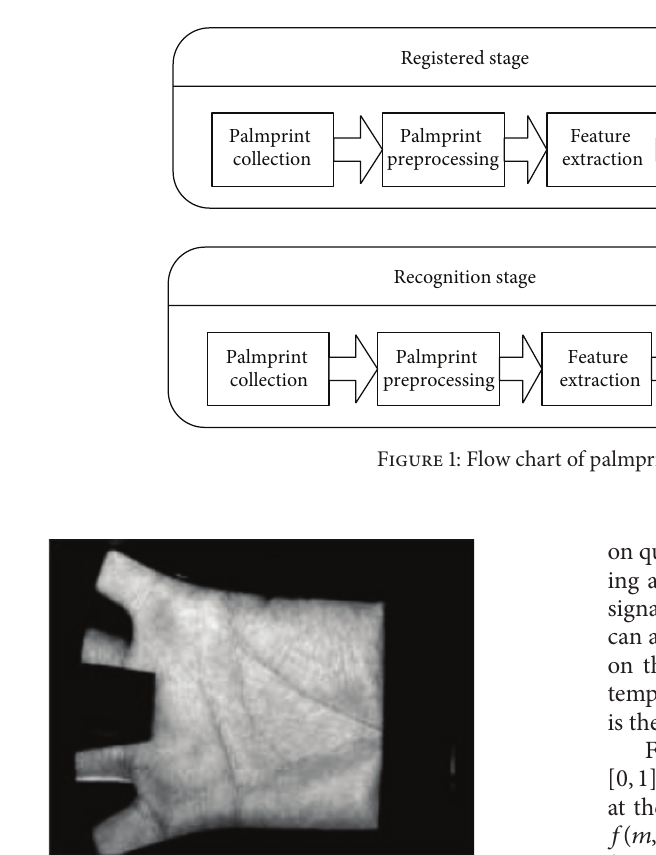
Figure 2: Original